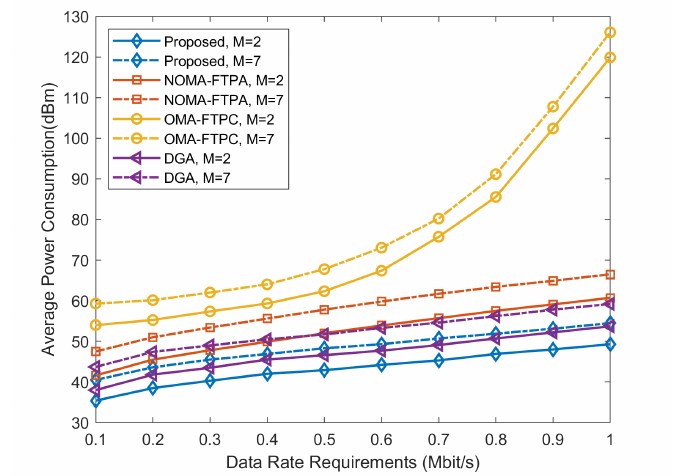
Figure 3. Power consumption for different numbers of BSs versus different data rate requirements.